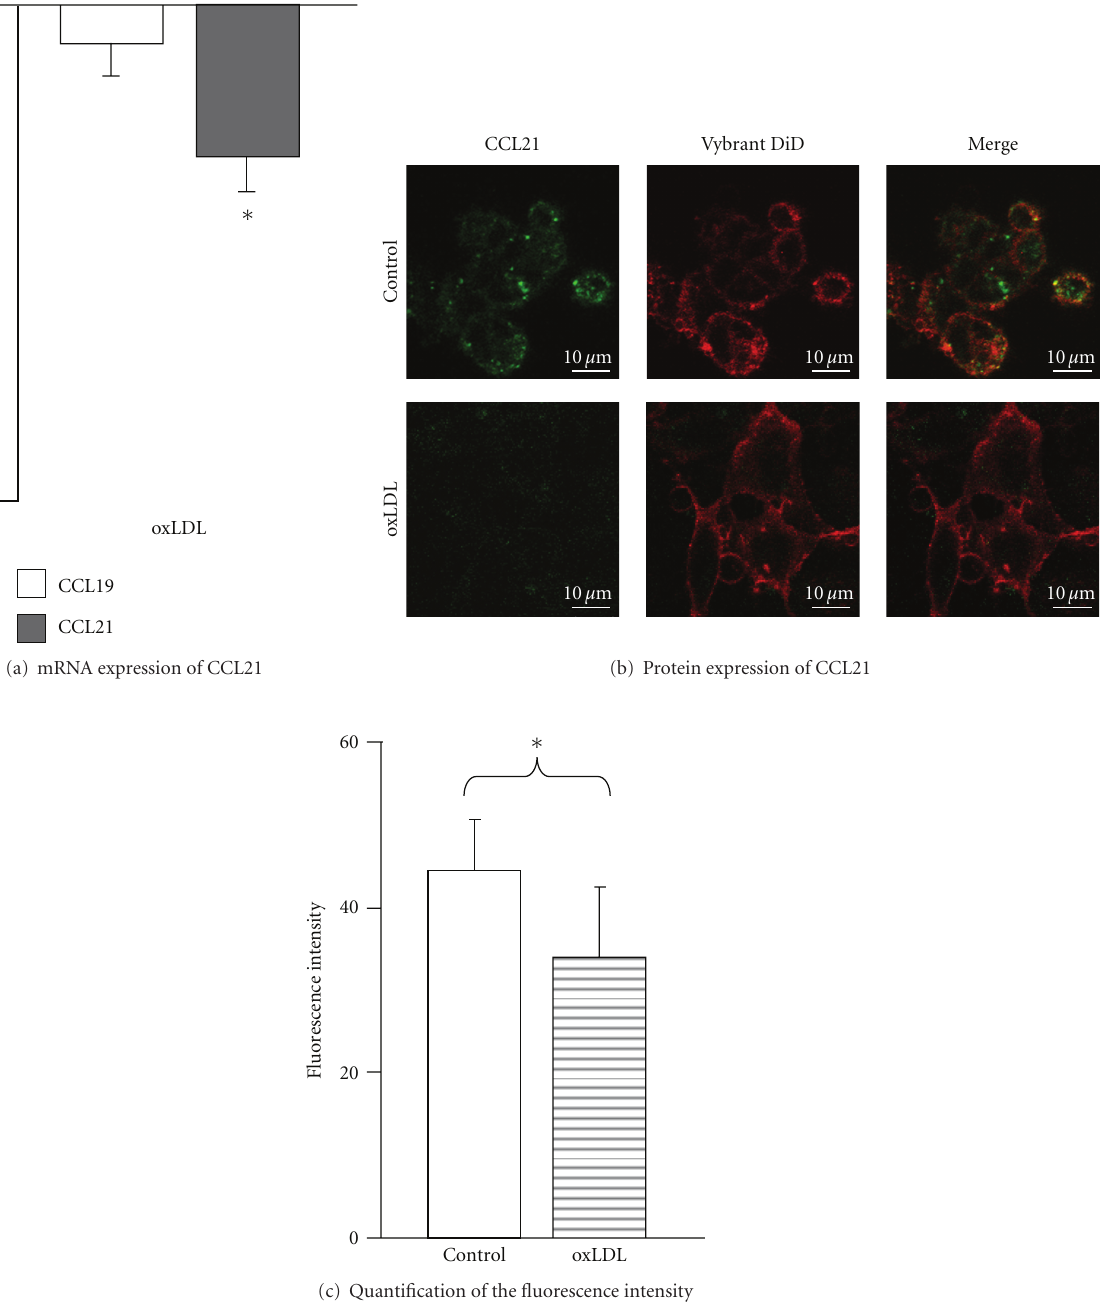
Figure 4: mRNA expression of CCL21/19 and protein expression of CCL21 on HMECs-1 after stimulation with oxLDL. (a) Fold increase in mRNA expression levels of CCL21/19 in human microvascular endothelial cells after 48 h of stimulation with oxLDL (10 μ g/mL) analyzed by real-time PCR. ∗ P < 0 . 05, ( n = 9) versus unstimulated controls. (b) Corresponding protein expression of CCL21 measured by immunofluorescence analysis. The green staining represents CCL21 positive structures ( α -CCL21/6Ckine-Alexa488), red represents the plasma membrane (Vybrand DiD). Scale bar 10 μ m. (c) The fluorescence intensity was quantified showing a significant change for oxLDL. ∗ P < 0 . 05, ( n = 8) versus unstimulated